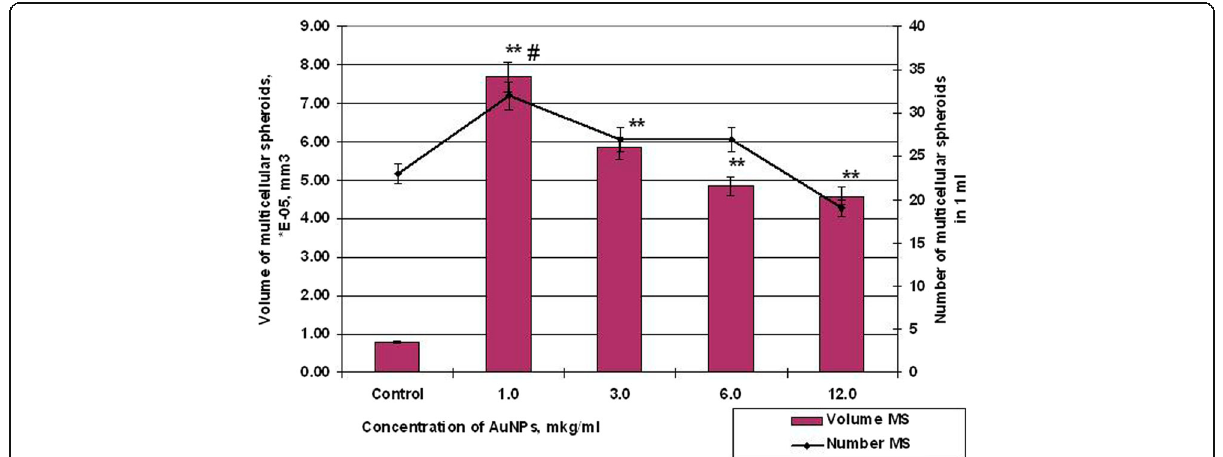
Fig. 6 Number and volume of MS cells SPEV after incubation with AuNPs, # p ≤ 0.01 (for number MSs); ** p ≤ 0.01 (for volume of MSs)